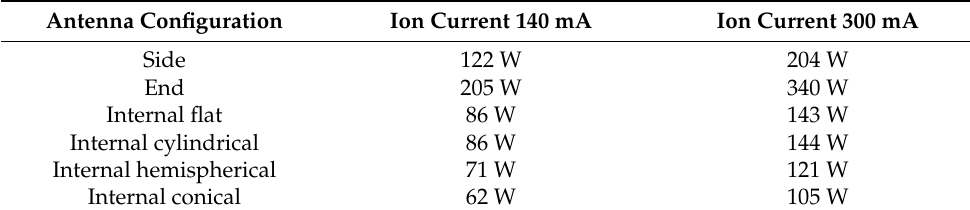
Figure 10. Two-dimensional distribution of charged particle density over the DC volume in the case of using an internal antenna with conical arrangement of turns: ( a ) xenon flow rate of 0.5 mg/s, RF power of 62 W, extracted ion current of 140 mA; ( b ) xenon flow rate of 1 mg/s, RF power of 105 W, extracted ion current of 300 mA. Table 1. RF power required to provide the given extracted ion current at a constant propellant flow rate (0.5 mg/s for an ion current of 140 mA and 1 mg/s for an ion current of 300 mA).